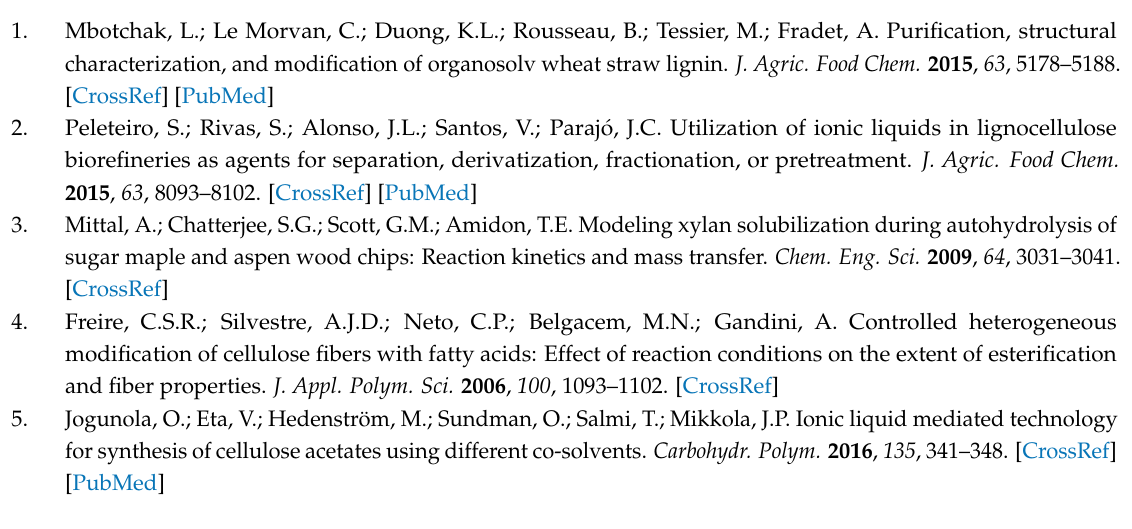
Table S1: Weight-average ( M w ), number-average ( M n ) molecular weight, and polydispersity ( M w / M n ) of the samples. Acknowledgments: This work was financially supported by the National Program for Support of Top-Notch Young